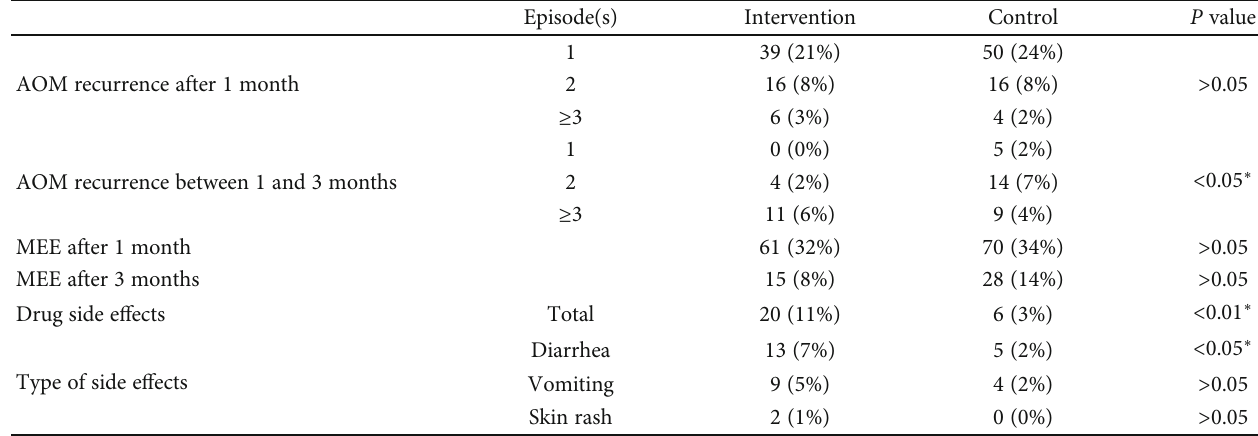
Table 4: Follow-up fi ndings in patients after the